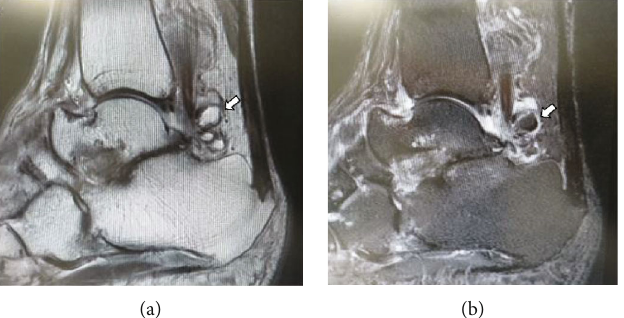
Figure 4: Magnetic resonance imaging shows several small fusiform masses (arrow) surrounded by a fl uid signal on T2-weighted (a) and short T1 inversion recovery (b) scans in the sagittal plane.